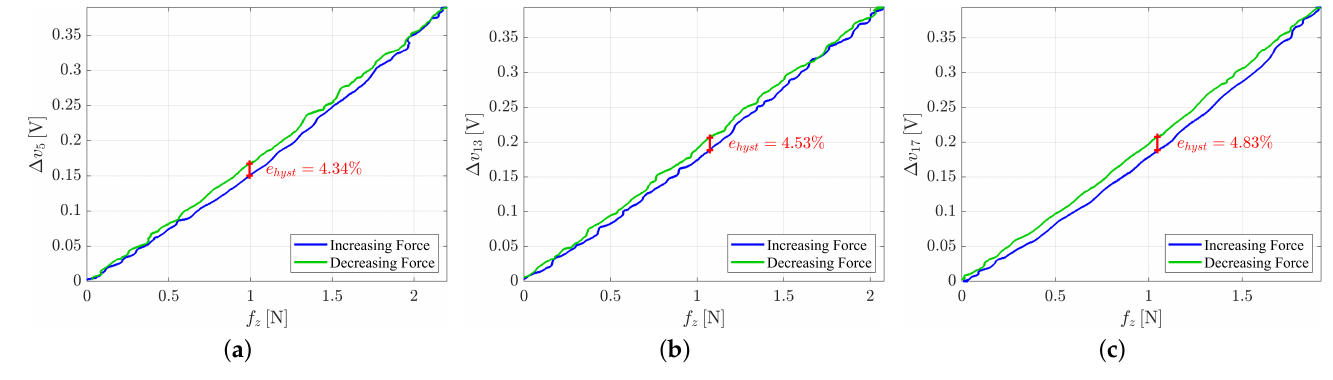
Figure 9. Hysteresis graphs for taxel 5 ( a ), taxel 13 ( b ) and taxel 17 ( c ). Repeatability . The repeatability error has been evaluated by repeating the same experiment carried out for the hysteresis two times consecutively, as shown by force and voltages data reported in Figure 10. The two rising edges have been compared, by reporting on the graphs the force values on the x -axis and the voltage values on the y